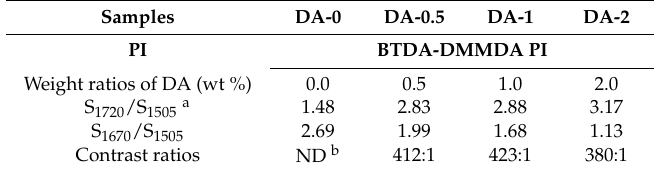
Table 1. Intensities variation of carbonyl groups before and after photoirradiation and contrast ratios of LC cells.